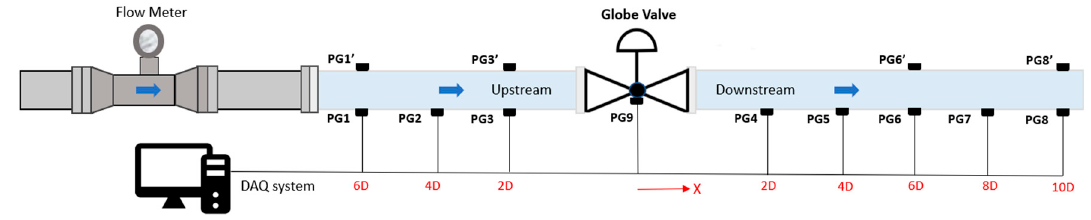
Figure 2. Schematic of the test section.